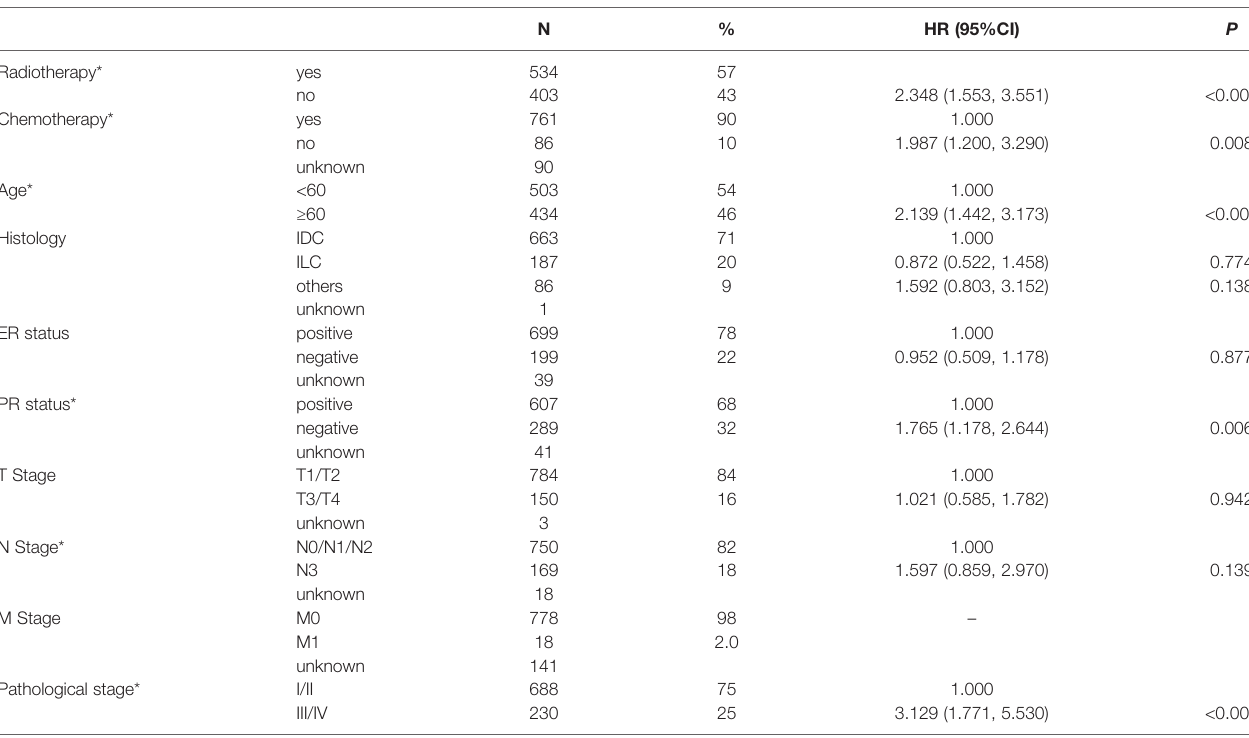
TABLE 1 | Associations of clinical variables with OS in BRCA (total N =